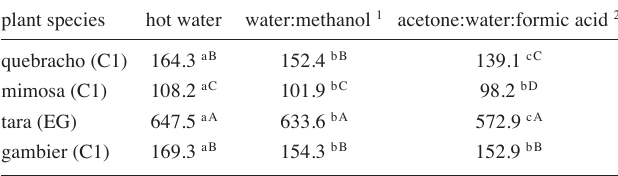
Tab. 4: Tannin content of the extracts in g kg −1 by HPLC-MS analysis with different extraction methods, quantification based on procyanidin C1 (C1) and epigallocatechin gallate (EG), respectively (standard error = 1.3).